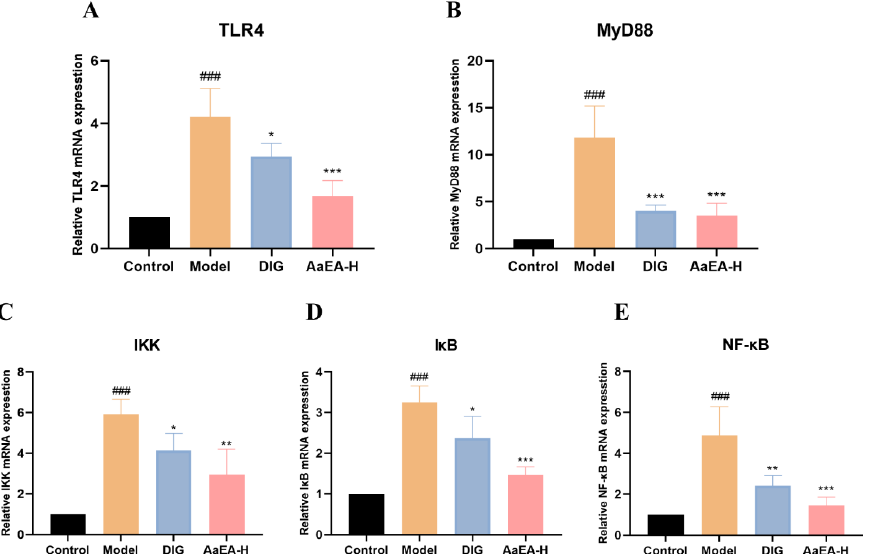
Figure 9. Effects of AaEA-H on each relative target gene of the TLR4/MyD88/NF- κ B pathway (n = 3). Relative TLR4 mRNA expression level in other groups compared with the control group ( A ). Relative MyD88 mRNA expression level ( B ). Relative IKK mRNA expression level ( C ). Relative I κ B mRNA expression level ( D ). Relative NF- κ B P65 mRNA expression level ( E ). Unless indicated, no significant difference was observed between groups. Compared with control group, ### p < 0.001. Compared with model group, * p < 0.05, ** p < 0.01, and *** p <